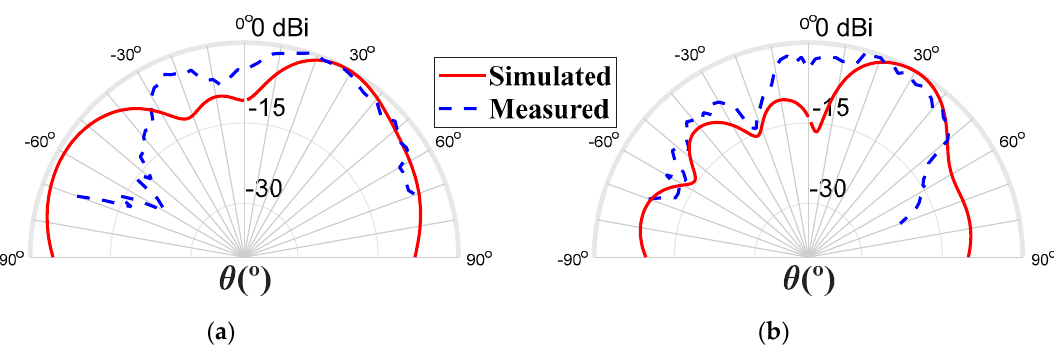
Figure 14. Radiation pattern to 29 GHz, ( a ) Plane φ =90 ⁰ and ( b ) Plane φ =0 ⁰ .